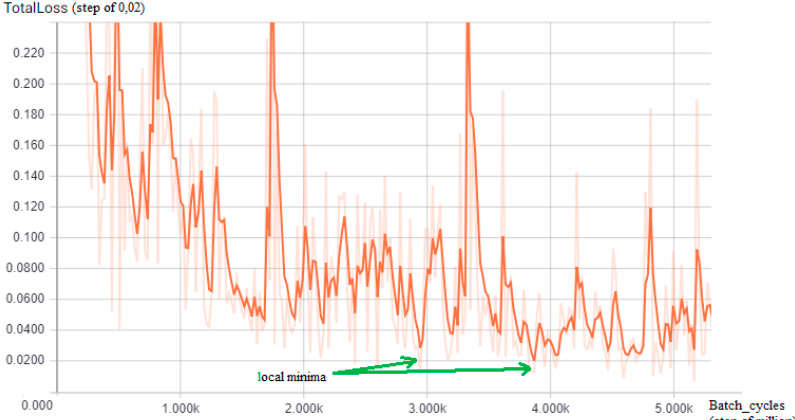
Figure 6. The TensorBoard graph of the loss function (y-axis, step of 0,02) on a subset of the training dataset for the license code area detector: Interesting local minima for the number of training batch cycles results in approximately 2,950,000 and 3,900,000 (green arrows, x-axis = batch size cycle amount, step of million).